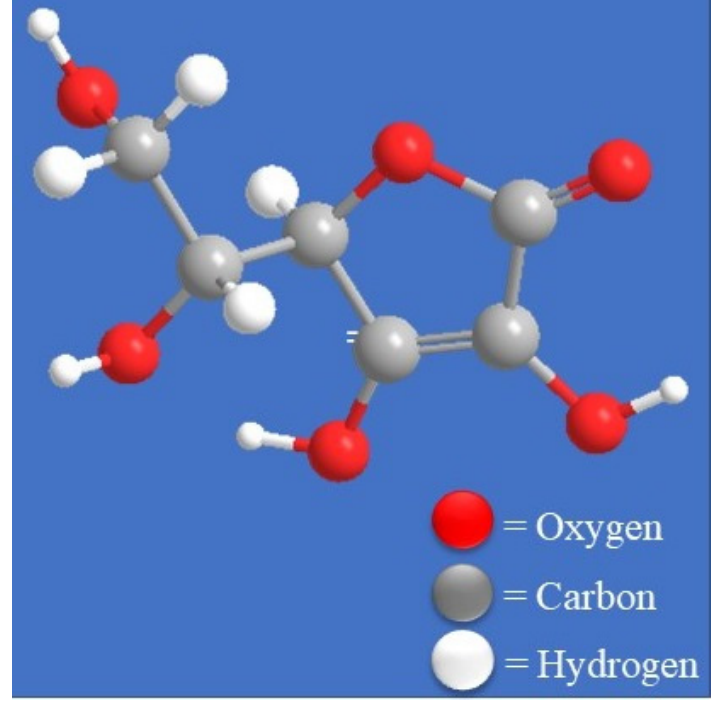
Figure 1. Chemical structure of ascorbic acid.